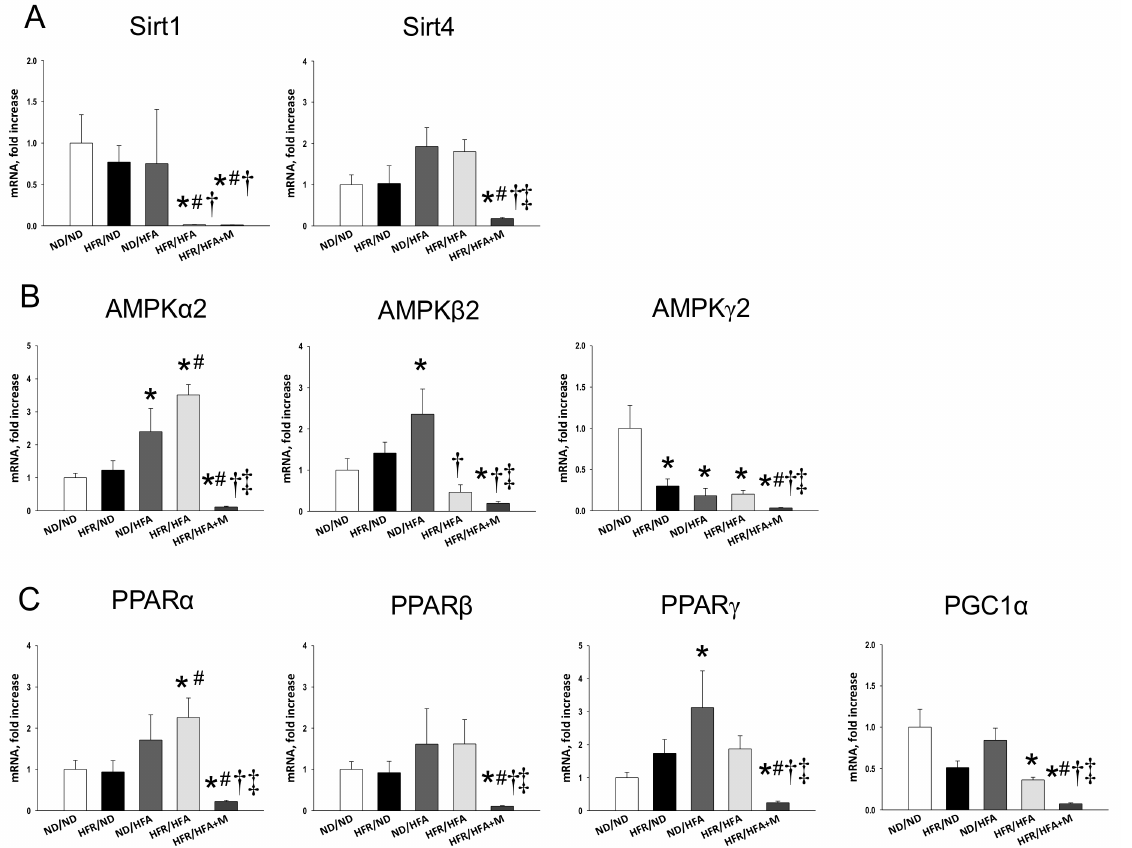
Figure 2. Effect of high-fructose diet (HFR), high-fat (HFA) diet, and metformin (M) on